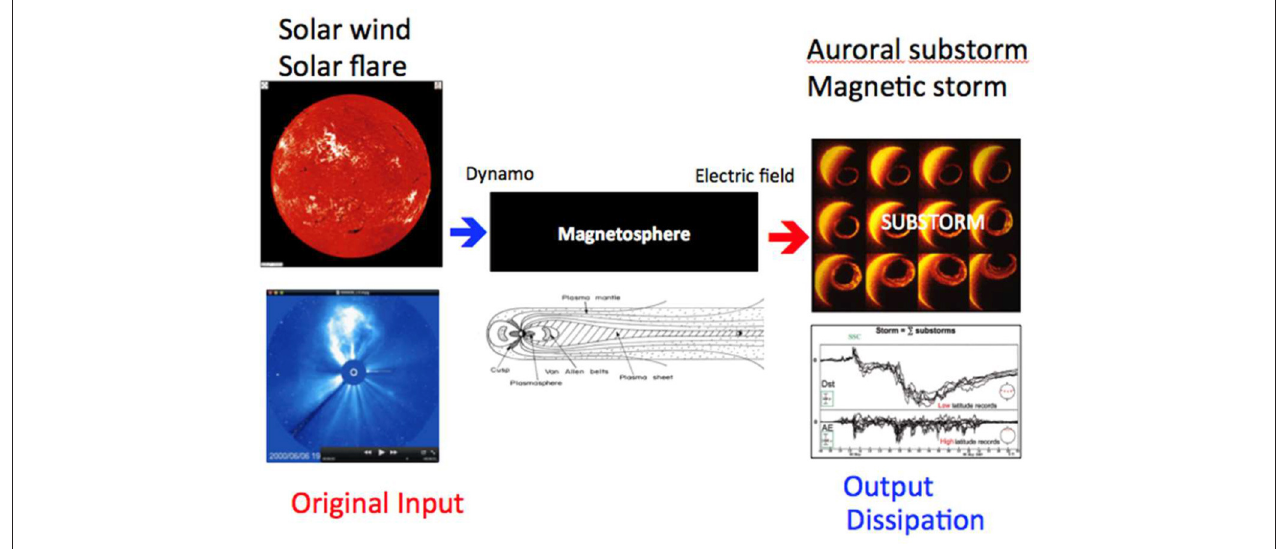
FIGURE 1 | The figure shows the overall solar-terrestrial relationship. The initial energy from the sun is carried by the solar wind to the magnetosphere. Auroral substorms and geomagnetic storms are two different aspects of the same phenomenon, which are end products (manifestations) of energy dissipation mainly in